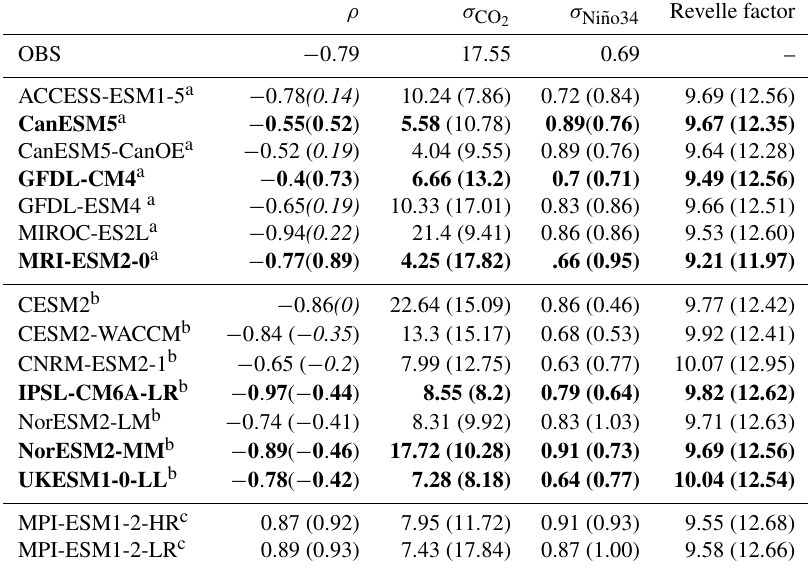
); in TgCm − 2 yr − 1 ) and the Niño34 index ( σ Ni ˜ no34 ); in ◦ C and their annual Table 3. Standard deviations of sea–air CO 2 fluxes ( σ CO 2 correlation coefficients ρ over the 1985–2014 period. In brackets are the standard deviation and correlation over the 2071–2100 period. The average Revelle factors for each model and both periods are also given. Models in bold have significant correlation for both periods and are the ones selected for the “reversed” and “preserved”